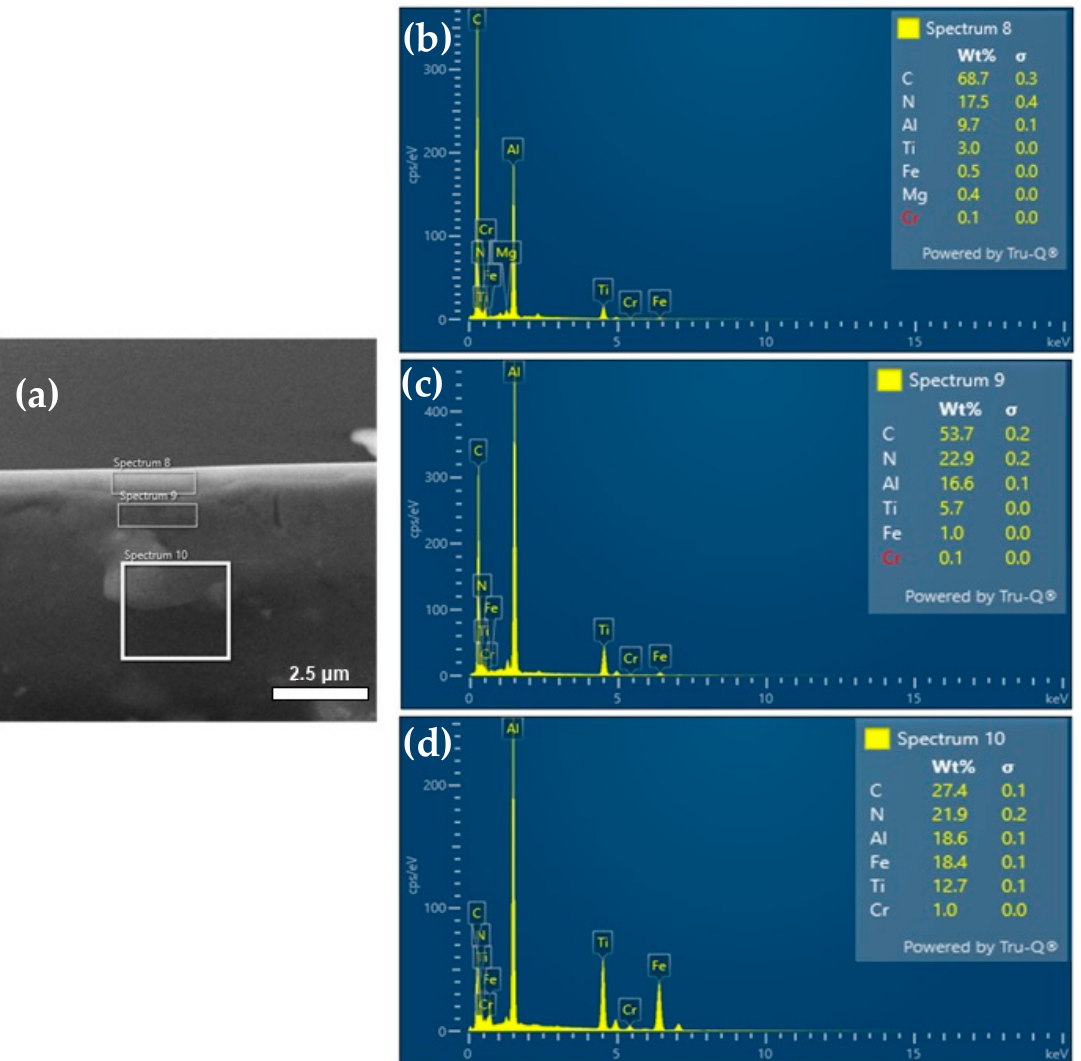
Figure 17. Selected site ( a ) for area analysis of the coating with the EDS recordings of individual elements: ( b ) EDS spectra of TiAlCN coatings, ( c ) EDS spectra of TiAlCN layer and partly of the substrate, ( d ) EDS spectra of substrate.